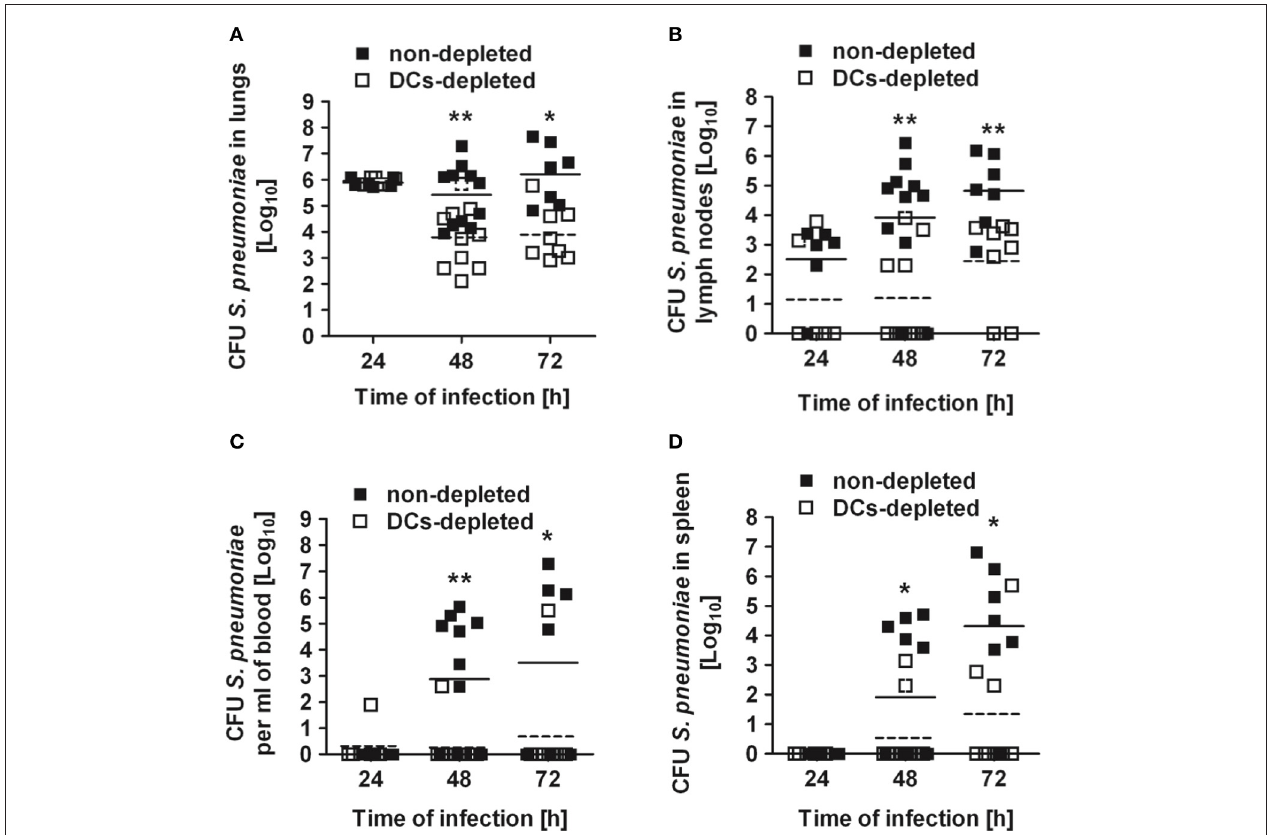
FIGURE 2 | Bacterial burdens in the organs of DCs-depleted and non-depleted mice after respiratory challenge with S. pneumoniae . DCs-depleted (white symbols) and non-depleted(black symbols) CD11c-DTR chimera mice were intranasally inoculated with 1 × 10 8 CFU of S. pneumoniae D39 and the bacterial loads determined in the lungs (A) ,